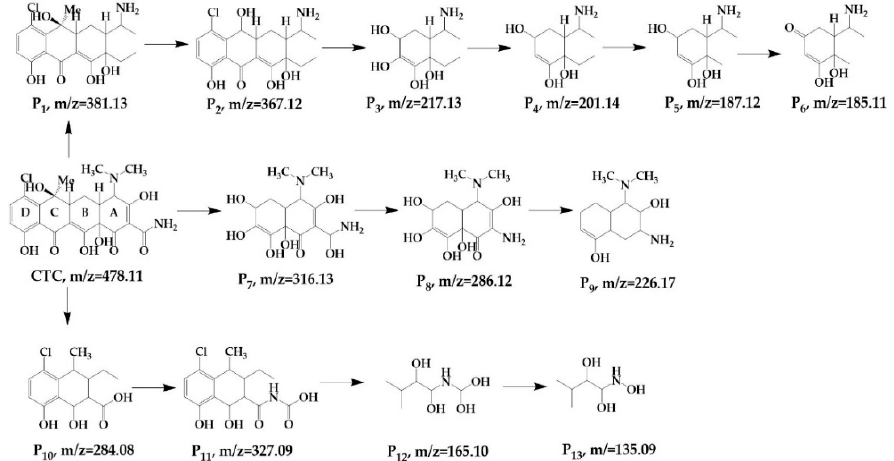
Figure 6. Possible pathways and degradation products of CTC by HC combined with H 2 O 2 .